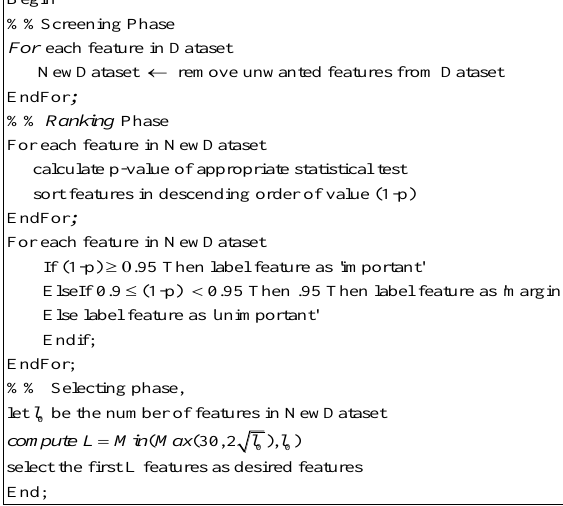
Figure 2. Feature selection algorithm pseudo-code. Table 1: Appropriate test used for evaluating different predictors for different